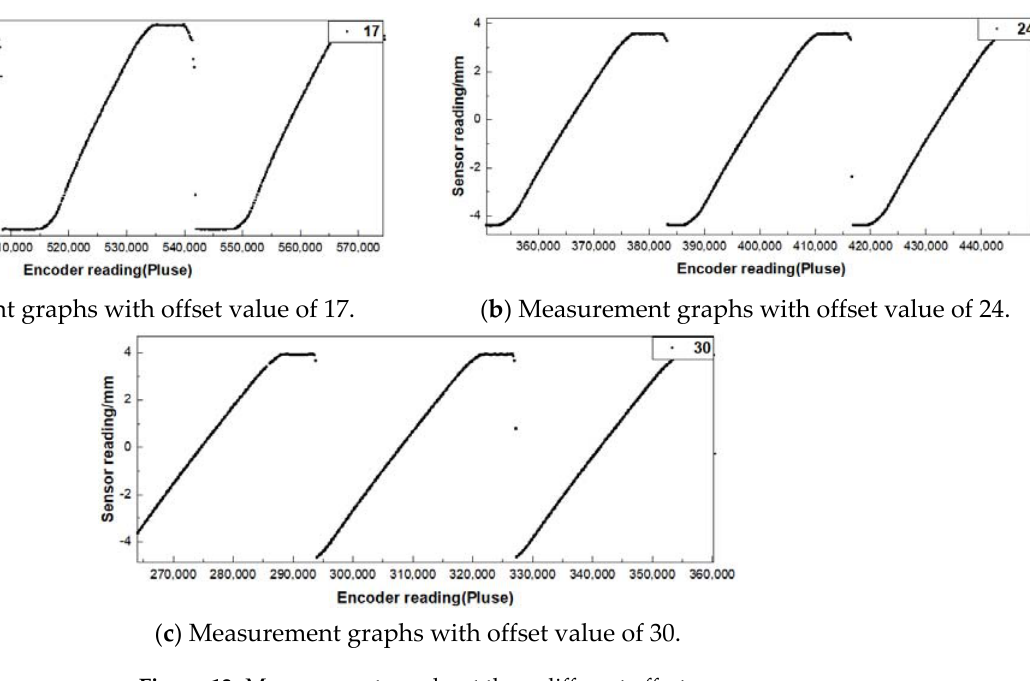
Figure 13. Measurement graphs at three different offsets. Table 1. Average number of effective data points for a single tooth under different